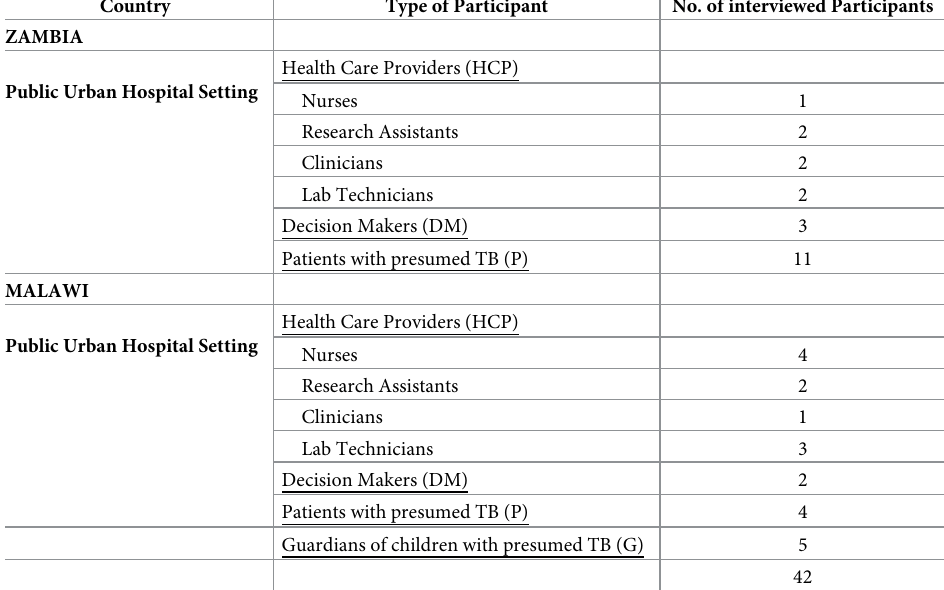
Table 1. Participants overview per